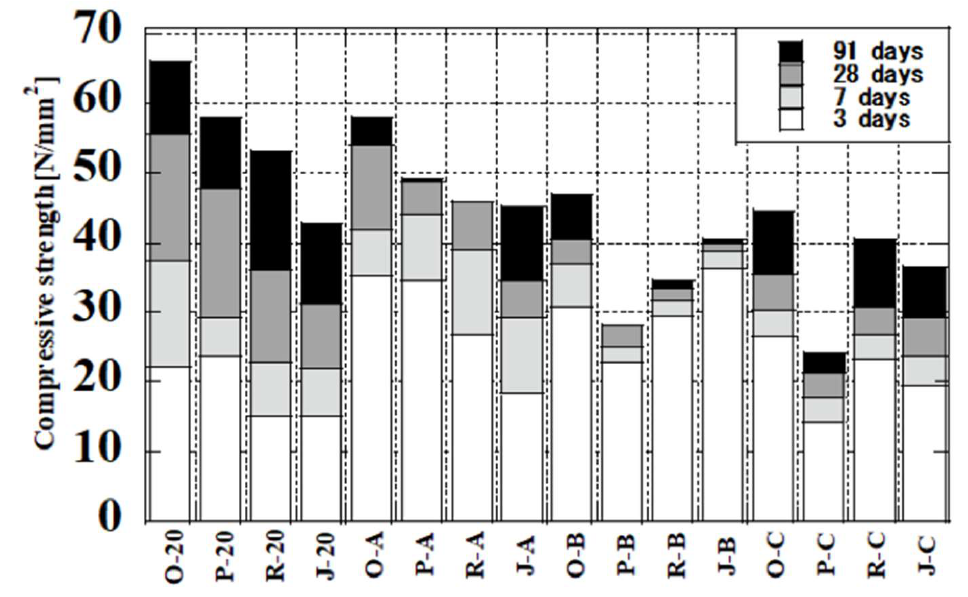
Figure 11. Compressive